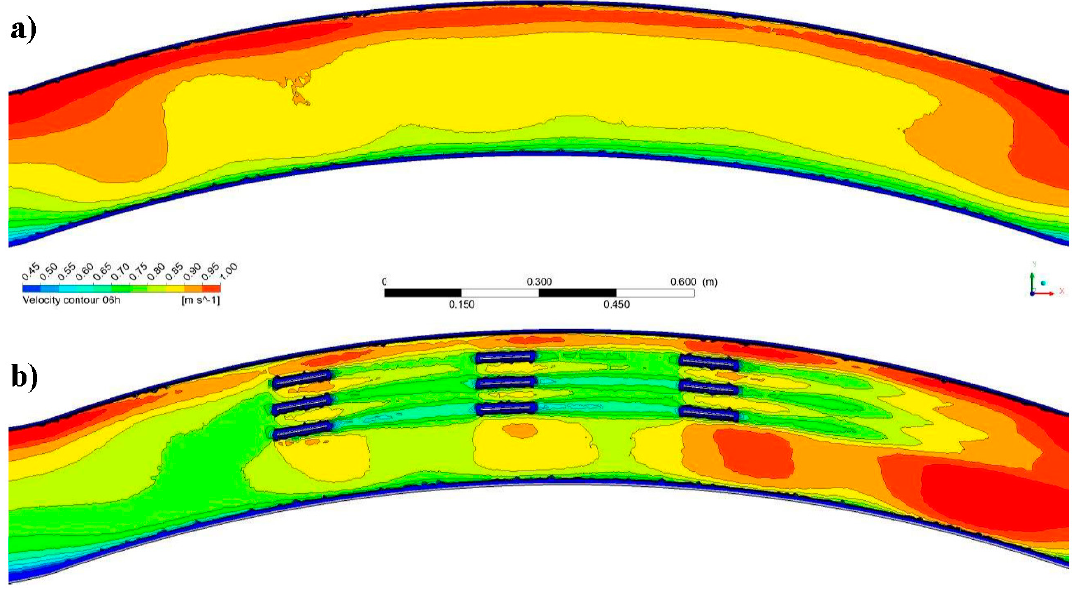
Figure 6. Velocity contour map at the water surface for: ( a ) without vane situation, ( b ) with vanes situation. Table 4. CFD and experimental velocity results for without vane situation at Section 1-1, 2-2, 3-3. Section